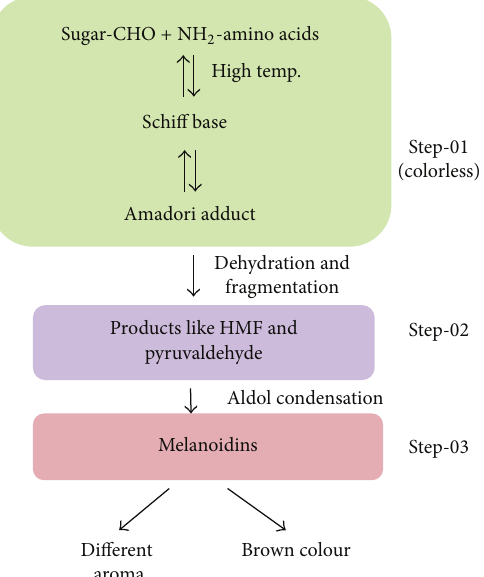
Figure 1: Schematic representation of “Maillard reaction” and flavour formation in